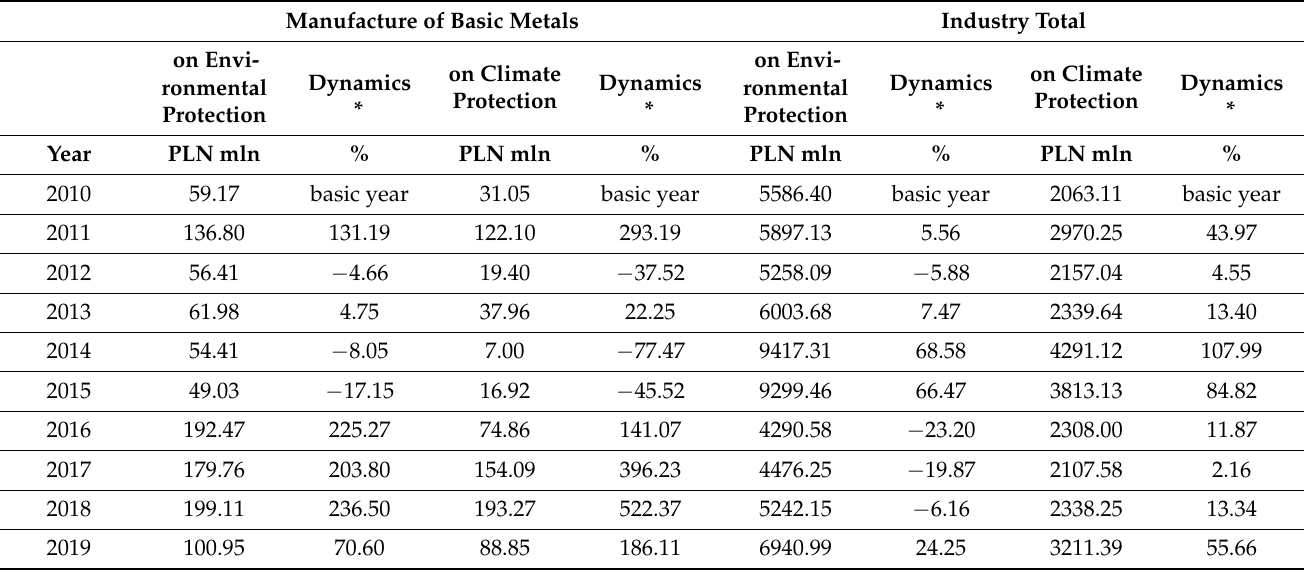
Figure 14. Amount of fixed assets in environmental protection in industry by investment in Poland. Source: adapted with permission from Refs. [101–109]. Table 7. Dynamics of amounts of fixed assets in environmental protection for basic year